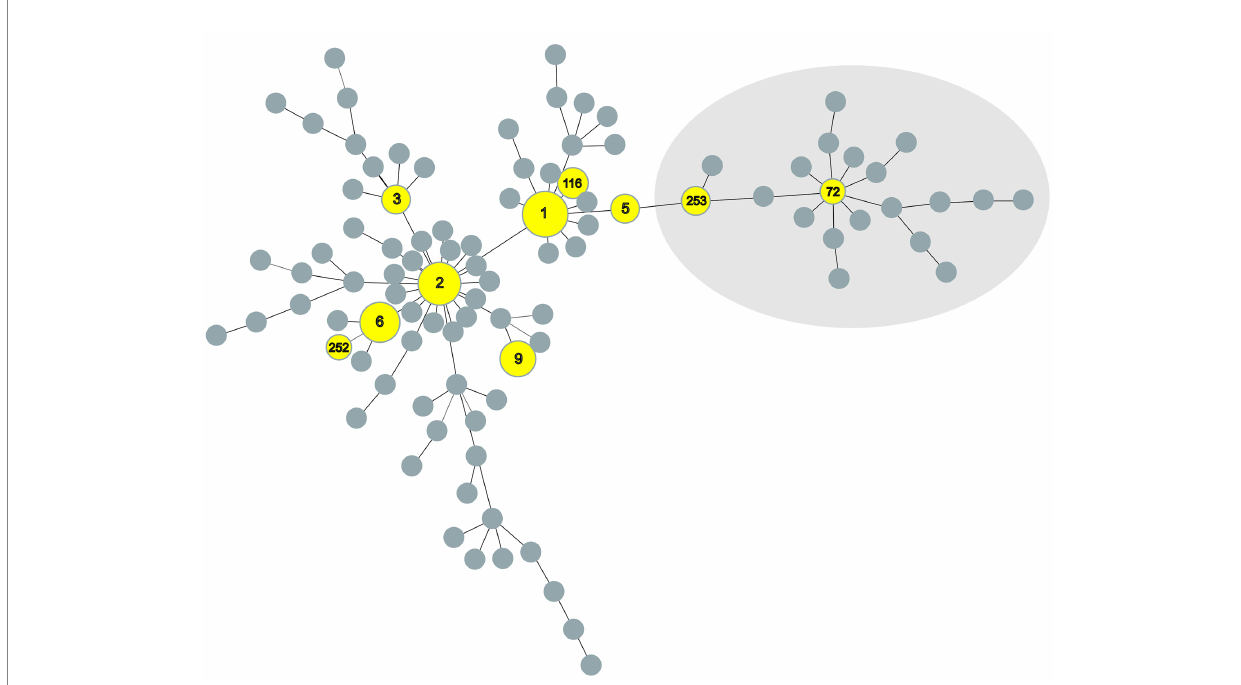
FIGURE 2 Minimum spanning tree of all Mycobacterium avium subspecies paratuberculosis INMV profiles registered at the MAC-INMV database (http://mac- inmv.tours.inra.fr/). Profiles that were also identified in this study or only in this study are colored in yellow. Grey nodes represent all INMV profiles registered at the MAC-INMV database. The size of these nodes reflects the number of epidemiologically unrelated samples harboring a specific INMV profile. INMV types 72 and 253, indicated in the light grey area, represent INMV profiles belonging to S-type M. avium subspecies paratuberculosis Type III. INMV; INRA Nouzilly MIRU-VNTR.